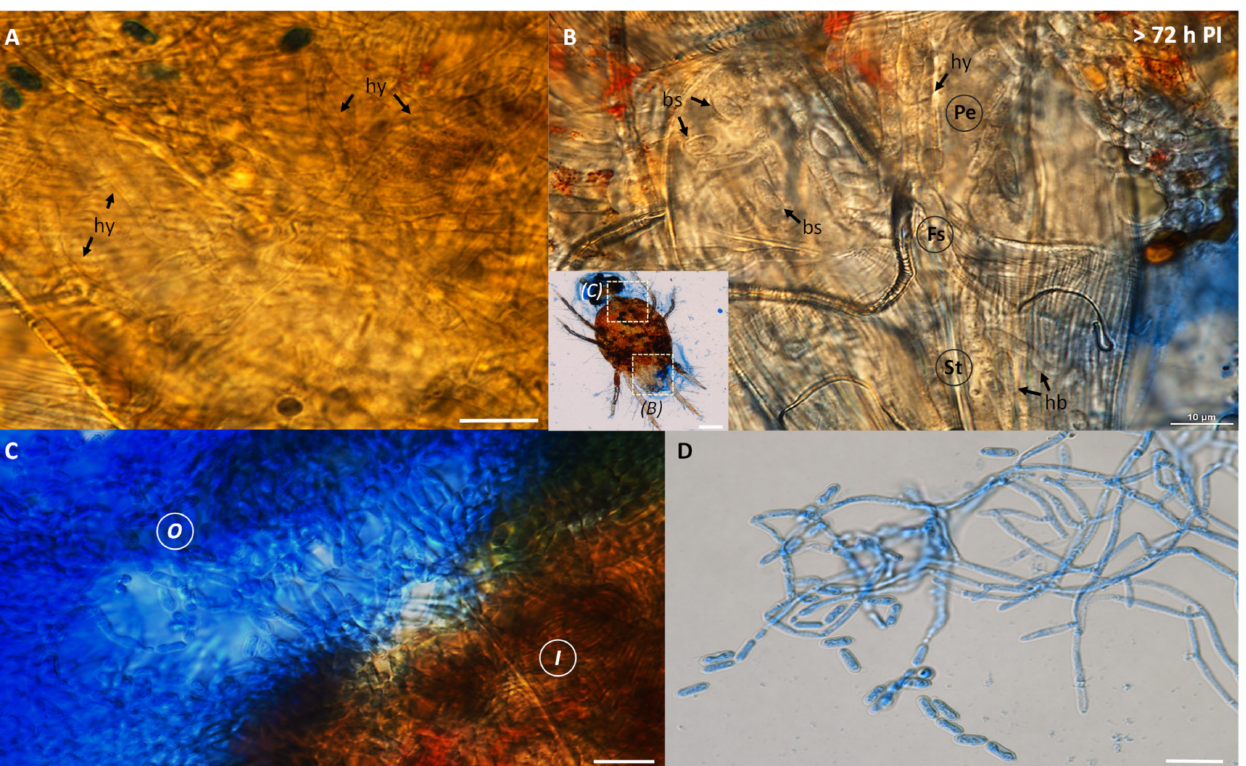
Figure 2. Light micrographs of dead cassava mites at a period longer than 72 h PI. ( A ) Several hyphae (hy) were observed inside the insect body. ( B ) A close-up view of anterodorsal section, including the feeding stylets (Fs), peritreme (Pe), and stylophore (St), showed numerous blastospores (bs) and hyphal bodies. ( C , D ) Dense mycelia and a mass of conidia appeared inside (I) and outside (O) of the hosts. Chains of cylindrical-shaped conidia Metarhizium sp. BCC 4849 were also found at the exterior of the dead host. Bars, 10 µ